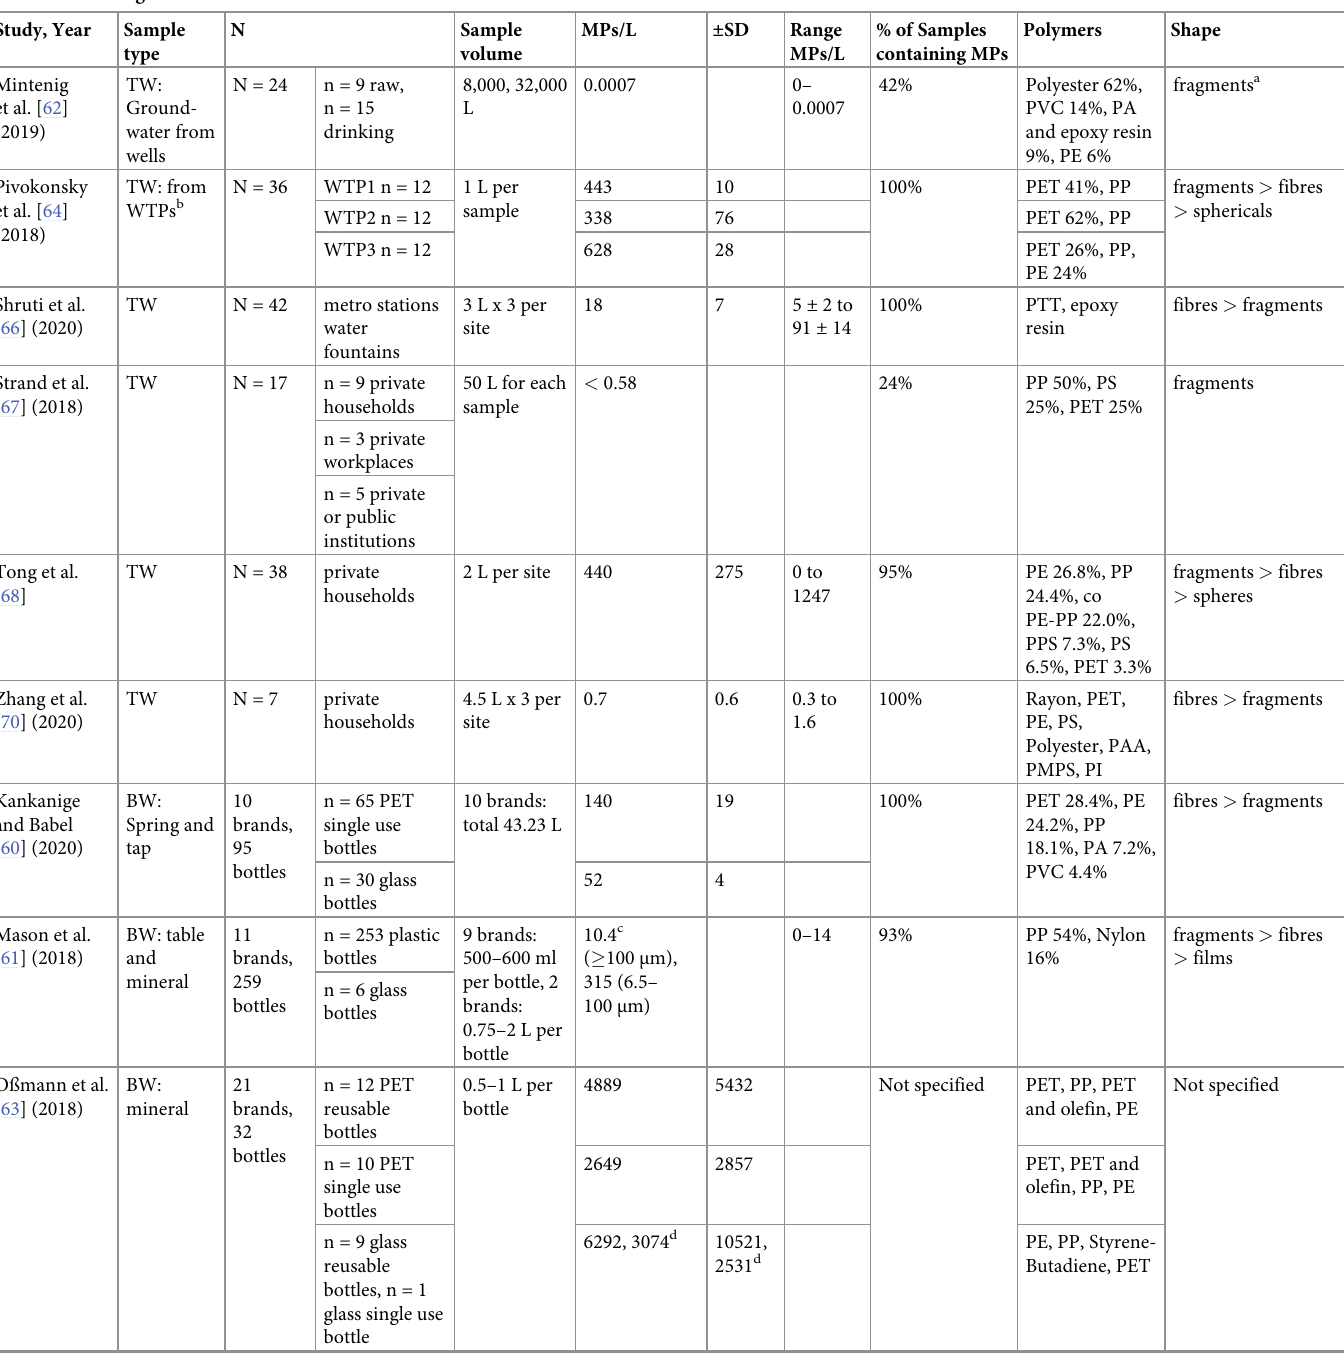
Table 1. Drinking water studies